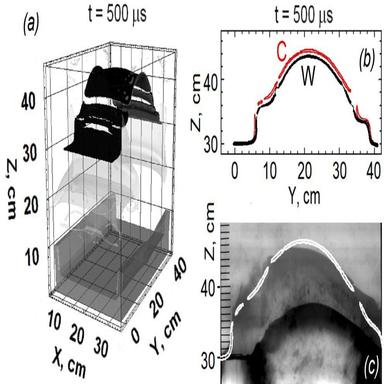
Results of the 3D-calculation for the rectangular plate test, ρ0 = 1.35 g/cm3 (a), compared at the median cross-section (curve W) with the same accuracy 2Dcalculation C (b). Comparison of a high accuracy 2D-calculation (white contour) with experimental flash X-ray image (upper shadow) (c).